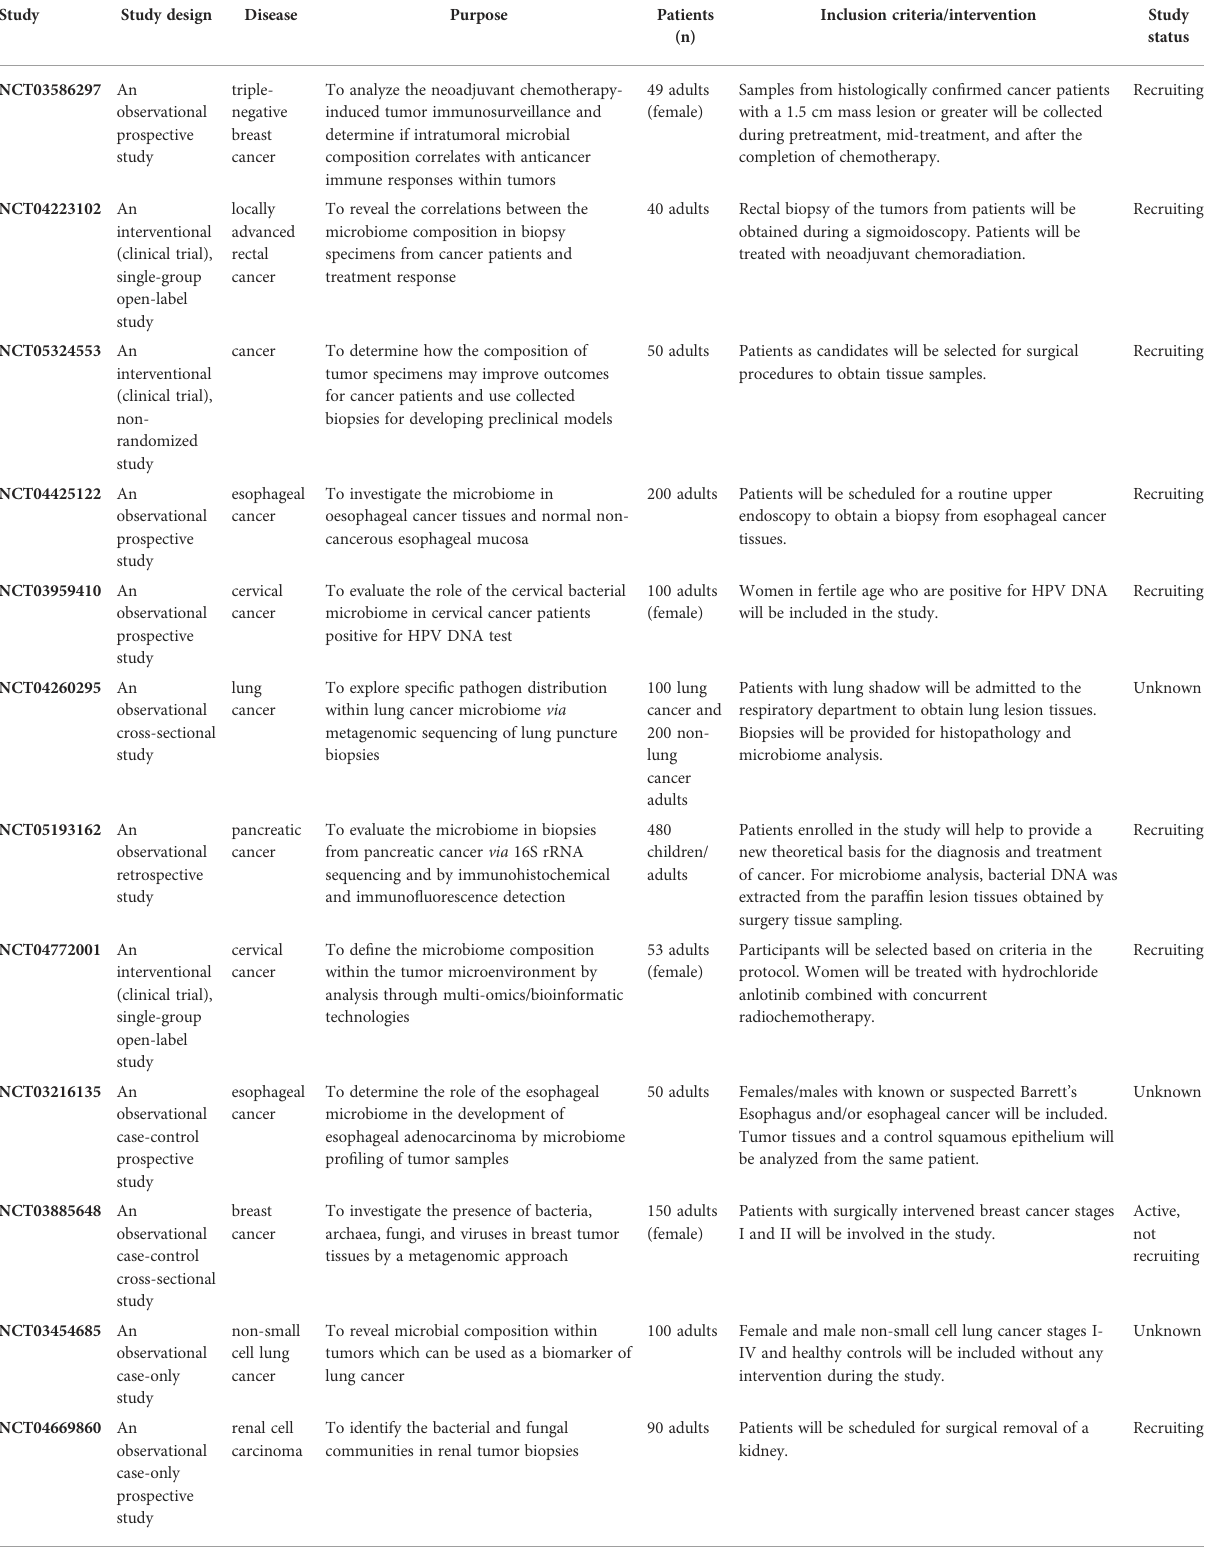
TABLE 1 Evaluating the role of tumor microbiome in different cancer